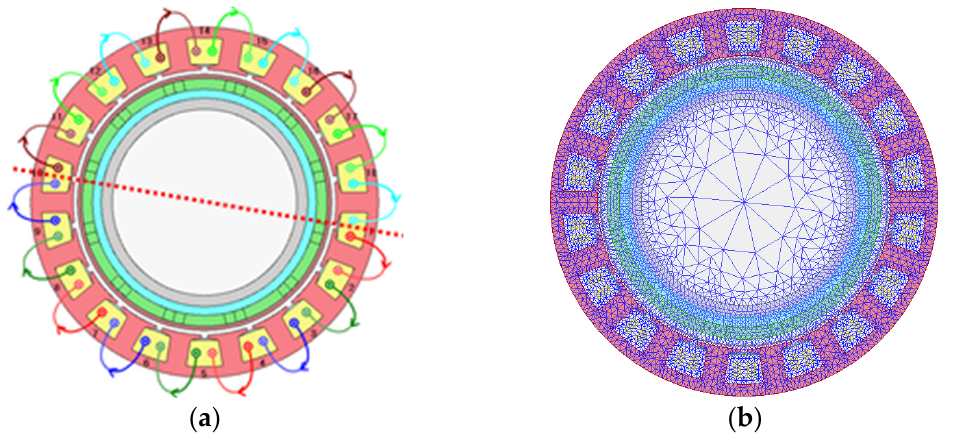
Figure 6. Dual three-phase, concentrated winding, 18 slot/12 pole in ANSYS Maxwell: ( a ) Topology model; ( b ) meshing plots.